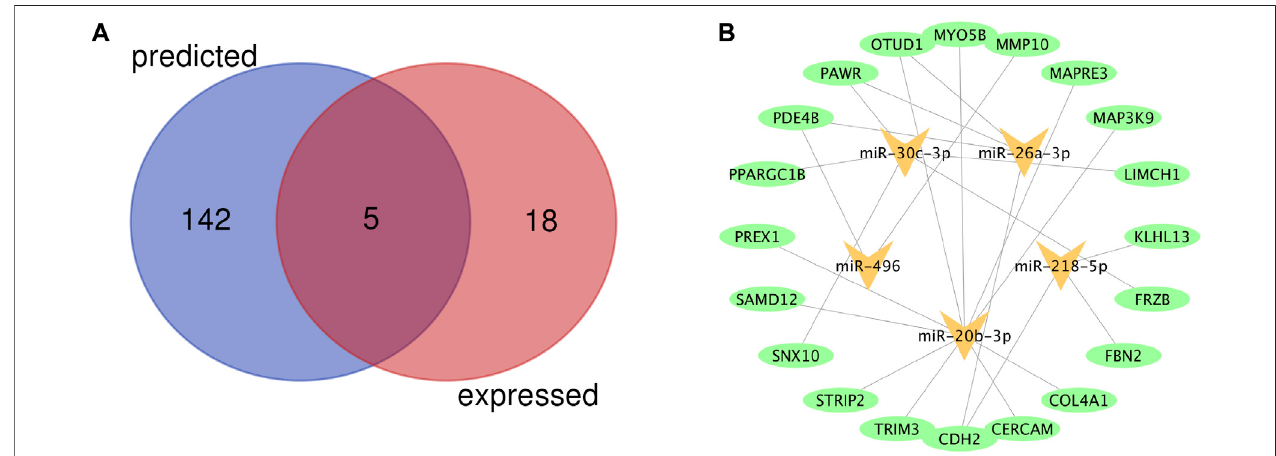
FIGURE 5 | Identi fi cation of key differentially expressed miRNAs (DEMs) and construction of DEM-DEG Pairs (A) Venn diagram of key differentially expressed miRNAs between predicted miRNAs and DEMs. (B) The kDEM – DEG pairs constructed by Cytoscape.